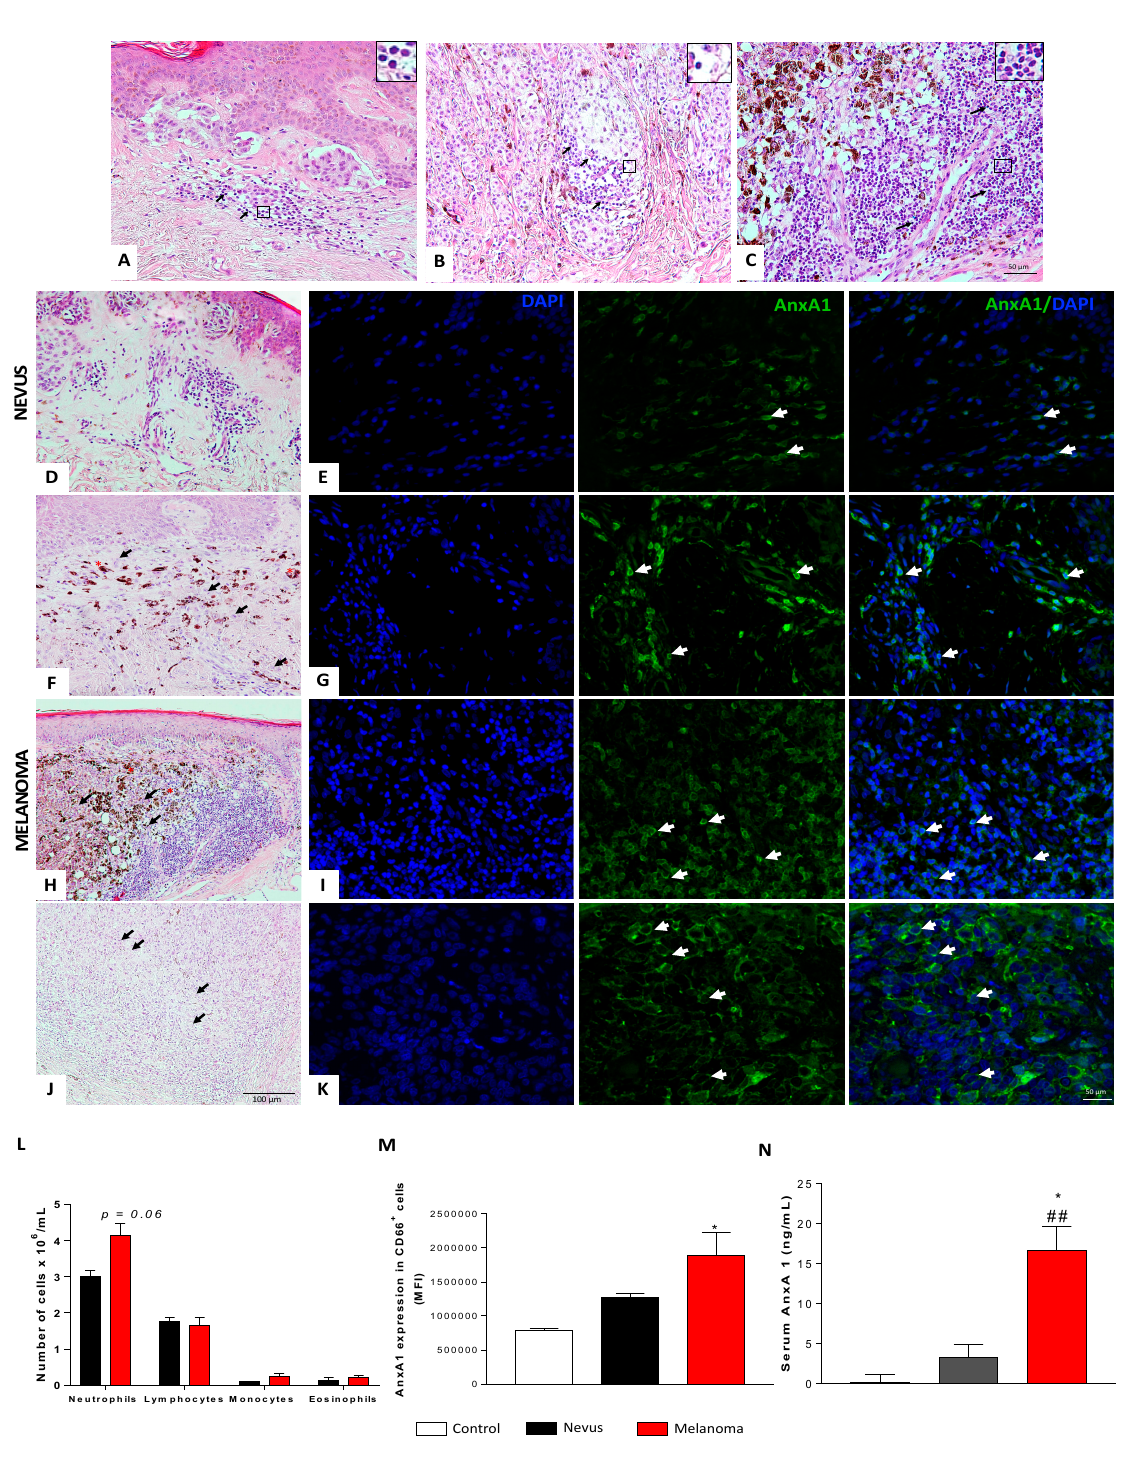
Figure 1. Expression and serum levels of AnxA1 were increased in melanoma patient samples. ( A – C ) Representative image of inflammatory infiltrate in biopsies obtained from melanoma patients— H&E staining (black arrows and inserts: lymphocytes). Scale bar: 100 μ m. ( D ) H&E staining and ( E ) AnxA1 expression detected by immunofluorescence in nevus sample. ( F , H , J ) H&E staining and ( G , I , K ) AnxA1 expression detected by immunofluorescence in melanoma cells from melanoma biopsies. (*) pigmented cells. (Black arrows) melanoma cells. (White arrows) AnxA1-labeled cells. Scale bar: 50 µ m. ( L ) Leukogram. ( M ) AnxA1 expression in circulating neutrophils (CD66 + ) evaluated by flow cytometer. ( N ) AnxA1 serum levels. The data represent the average ± SEM. Control ( n = 4); nevus ( n = 4–5); melanoma ( n = 5–9). * p < 0.05 vs. nevus; ## p < 0.01 vs.